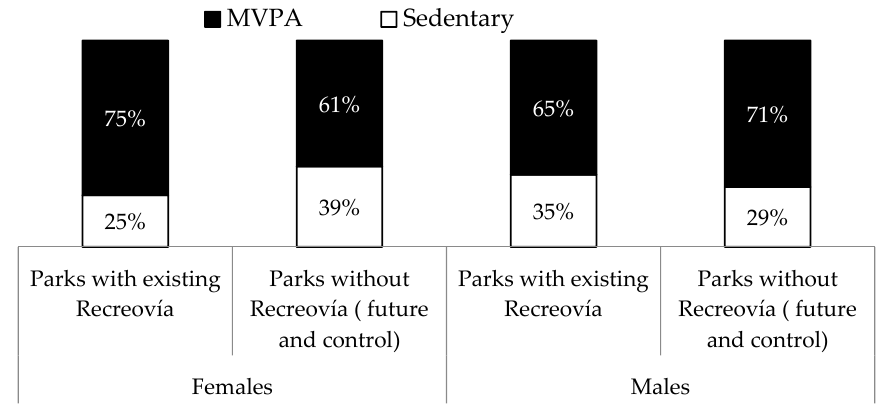
Figure 4. Physical activity intensity level (MVPA: moderate-to-vigorous physical activity) by gender and park program (existing Recreovía vs. no Recreovía program) in Bogotá, Colombia, 2013.